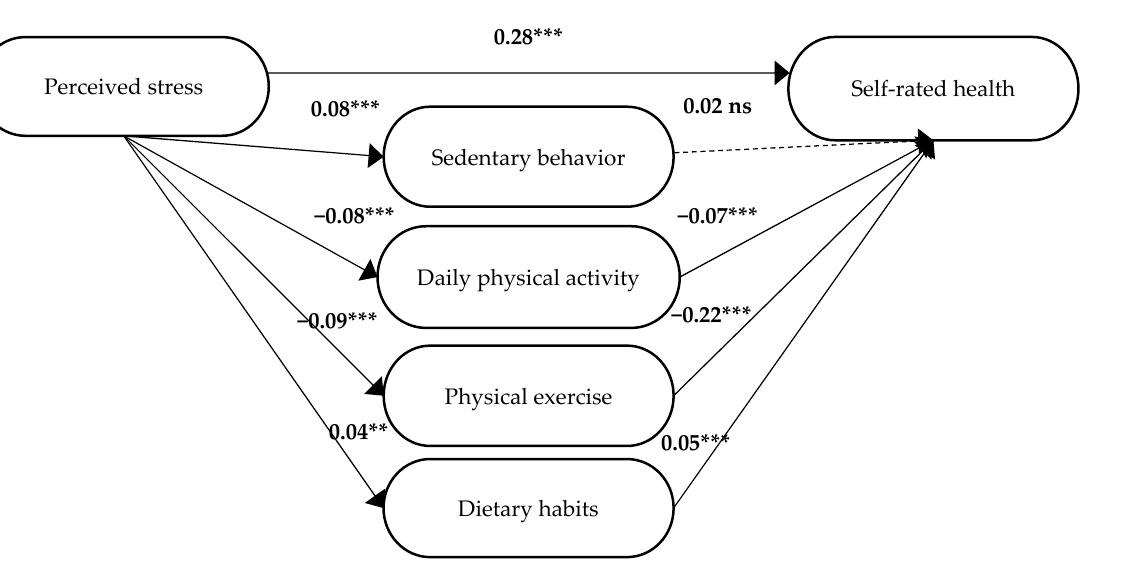
Figure 4. The final model for participants who did not report any of the requested diagnoses. The standardized beta coefficients ( β ) are included for the paths between the independent variable, i.e.,